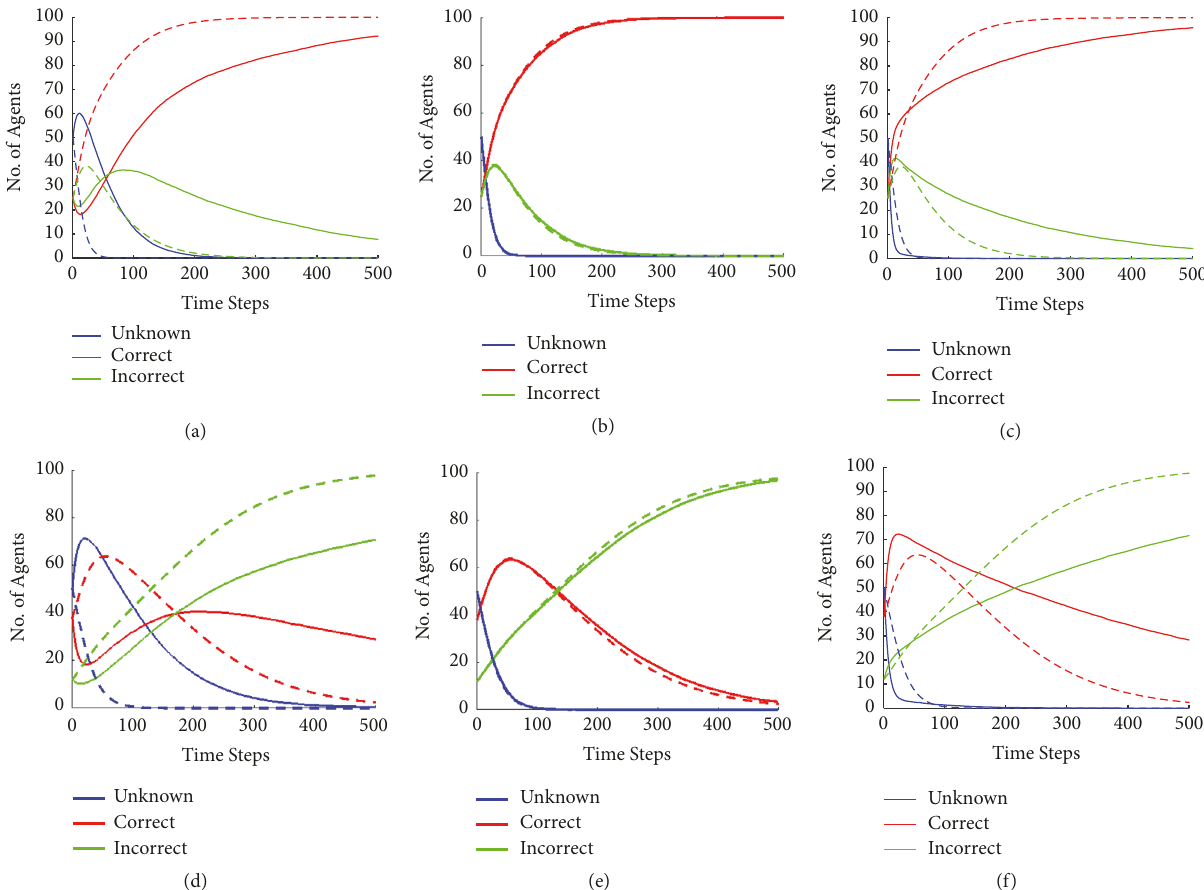
Figure 10: Dynamics in various configurations that result in similar mean trust against PBM against both scenarios. (a) LHH case in nominal; (b) MMM case in nominal; (c) HLL case in nominal; (d) LHH case in wishful-thinking; (e) MMM in wishful-thinking; (f) HLL in wishful-